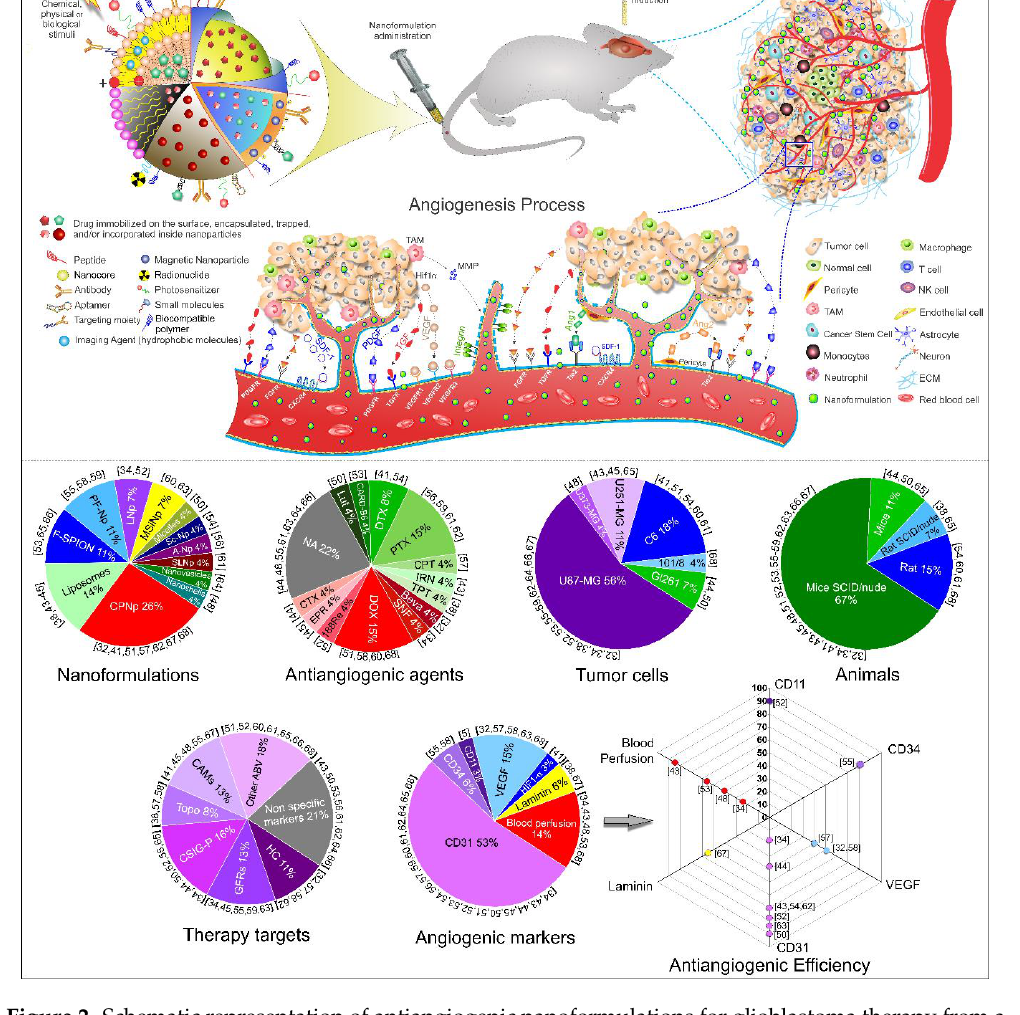
Figure 2. Schematic representation of antiangiogenic nanoformulations for glioblastoma therapy from a pre-clinical approach and the angiogenic process in the tumor microenvironment and the pie charts of the main results found in the systematic review, as well as the quantification of antiangiogenic efficiency appointed by each study. Abbreviations—188Re: Rhenium-188; ABV: Angiogenic blood vessels; Ang1: Angiopoietin